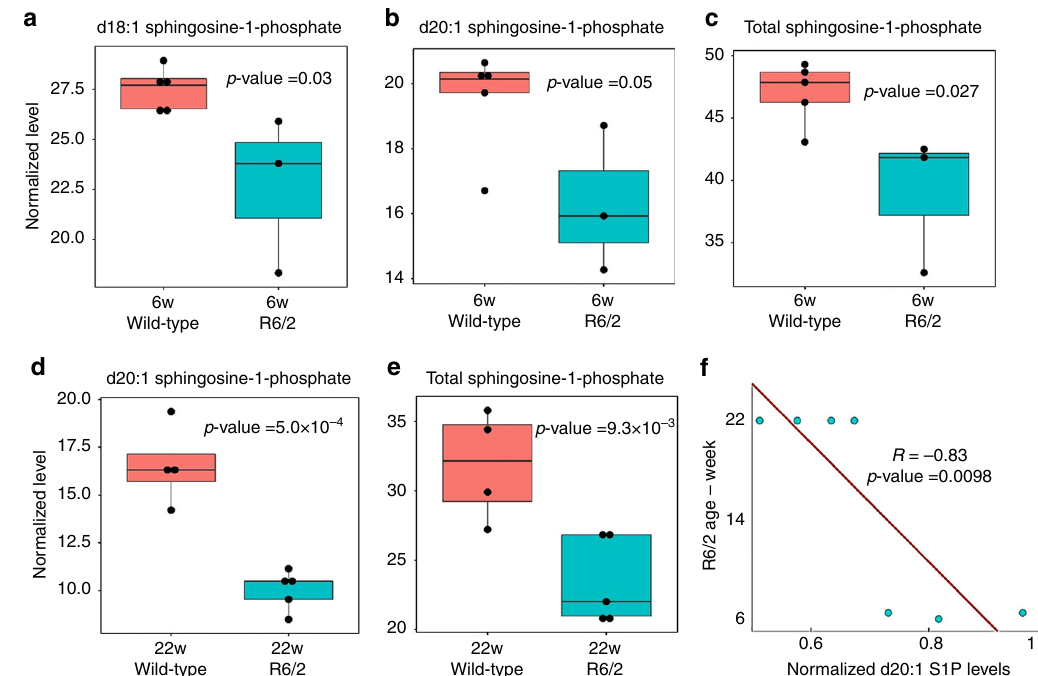
Fig. 5 Decreased levels of phosphorylated sphingoid bases in R6/2 mice. The box plots show the levels of phosphorylated sphingoid bases in 6-week-old and 22-week-old R6/2 mice and corresponding control animals. d18:1 S1P ( p = 0.03, ( a )), d20:1 S1P ( p = 0.05, ( b )), and total S1P ( p = 0.027, ( c )) levels are signi fi cantly decreased in 6-week-old R6/2 mice compared to controls. Additionally, d20:1 S1P ( p = 5.0 × 10 − 4 , ( d )) and total S1P ( p = 9.3 × 10 − 3 , ( e )) levels are signi fi cantly decreased in 22-week-old R6/2 mice compared to their corresponding wild-type animals. Two-tailed t -tests were performed to calculate statistical signi fi cance. Each boxplot shows the distribution of the levels of phosphorylated sphingoid bases. The top and the bottom of the boxplots show fi rst and third quartiles of each data set, and middle line show the medium. Statistical signi fi cant is calculated using two-tailed t -test. f The S1P levels are signi fi cantly anti-correlated with the age of R6/2 mice ( R = − 0.83, two-tailed t -test, p = 0.0098). The dots show the normalized S1P levels in 6-week-old R6/2 and 22-week-old R6/2 mice, in which the S1P levels are normalized by the mean of S1P levels in their age-matched controls. The line shows a fi tted linear regression model, predicting the age of the animals based on the S1P